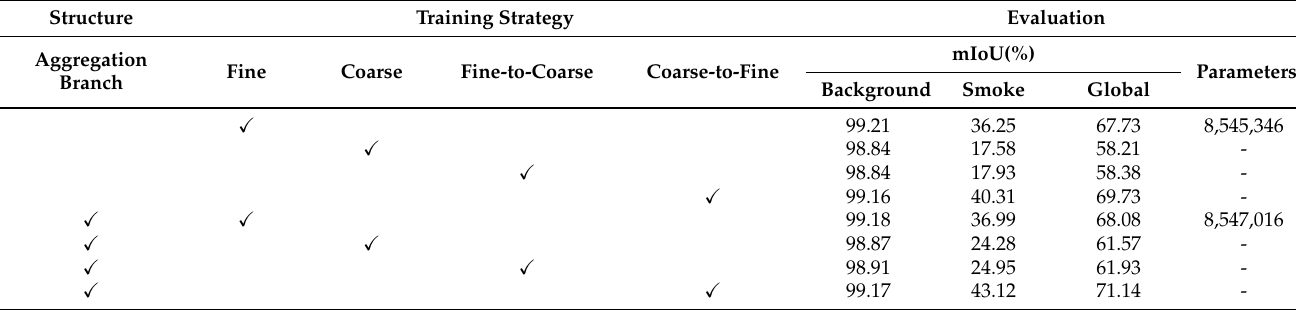
Table 2. Ablation study results on the PoVSSeg test